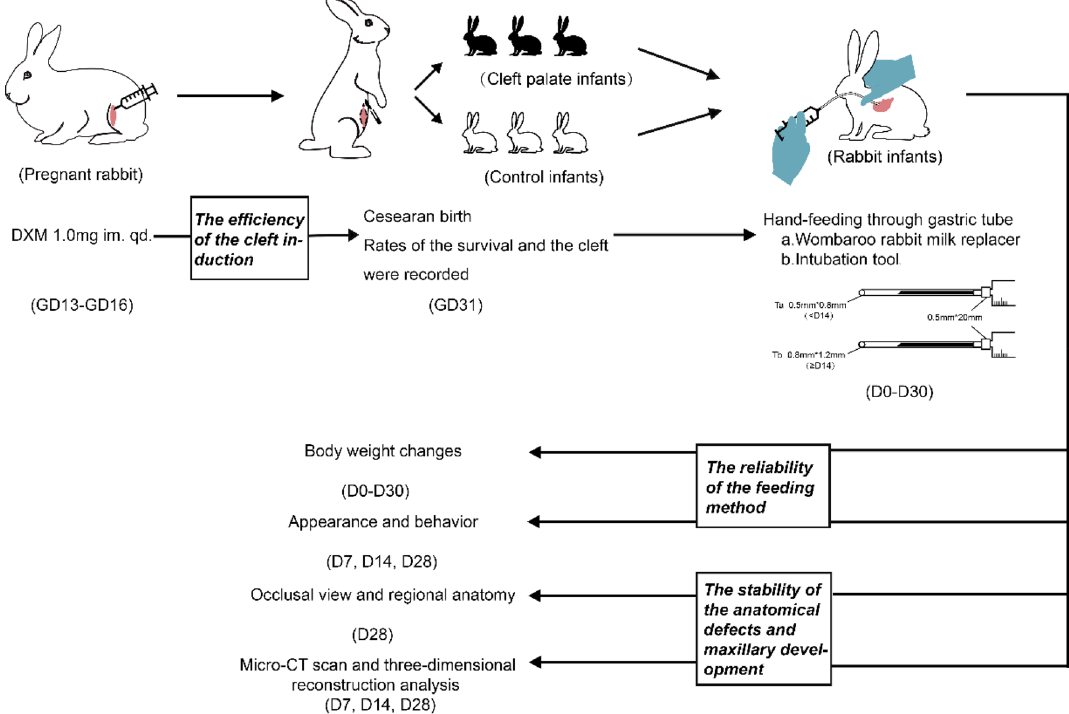
Figure 1. Procedures and descriptions of the congenital cleft palate rabbit model. DXM dexamethasone, D day (age of